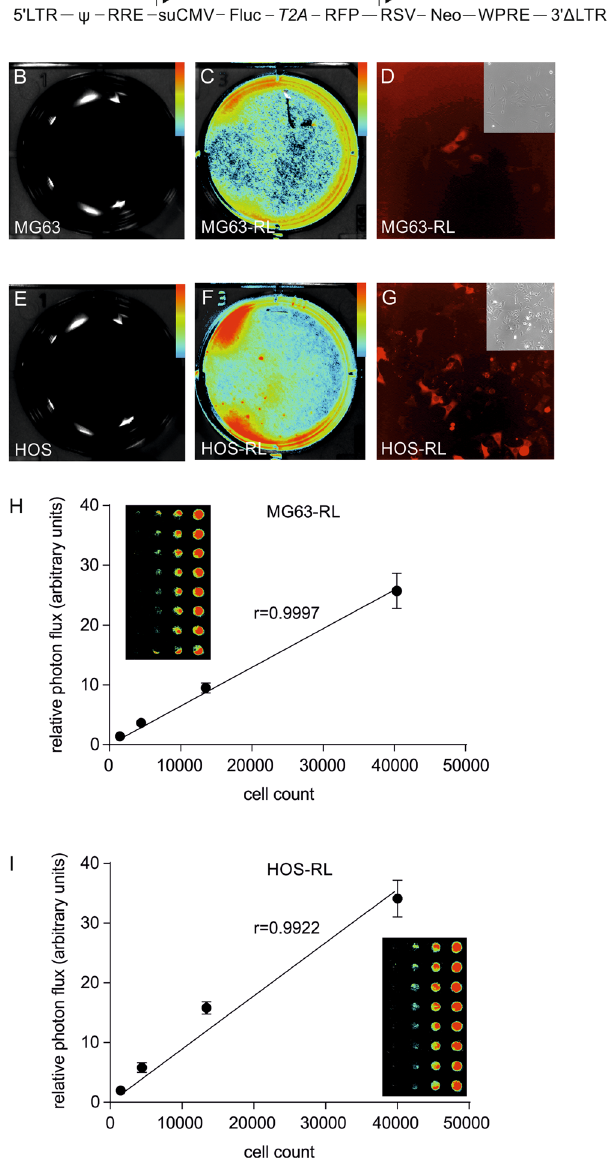
Figure 3. Validation of the reporter gene modified MG63-RL and HOS-RL cell lines. ( A ) Schematic presentation of the bicistronic lentiviral vector. ( B ) In vitro BLI of MG63 control cells. ( C ) In vitro BLI of MG63-RL cells. ( D ) Fluorescence microscopy on MG63-RL cells. The insert shows the corresponding brightfield image. ( E ) In vitro BLI of HOS control cells. ( F ) In vitro BLI of HOS-RL cells. ( G ) Fluorescence microscopy on HOS-RL cells. The insert shows the corresponding brightfield image. ( H ) Correlation of Bioluminescent light production and MG63-RL cell number. ( I ) Correlation of bioluminescent light production and HOS-R cell number. All color bar inserts range from 0 (blue) to 16383 (red) units photon flux. Abbreviations: Ψ , psi packaging sequence; RRE, rev response element; suCMV, CMV cytomegalovirus promoter; Fluc, firefly luciferase; T2A, thoseaasigna virus 2A self-cleavage peptide; RFP, red fluorescent protein; RFP; RSV, rouse sarcoma virus promoter; Neo, neomycin locus; WPRE, woodchuck hepatitis virus post‐ transcriptional regulatory